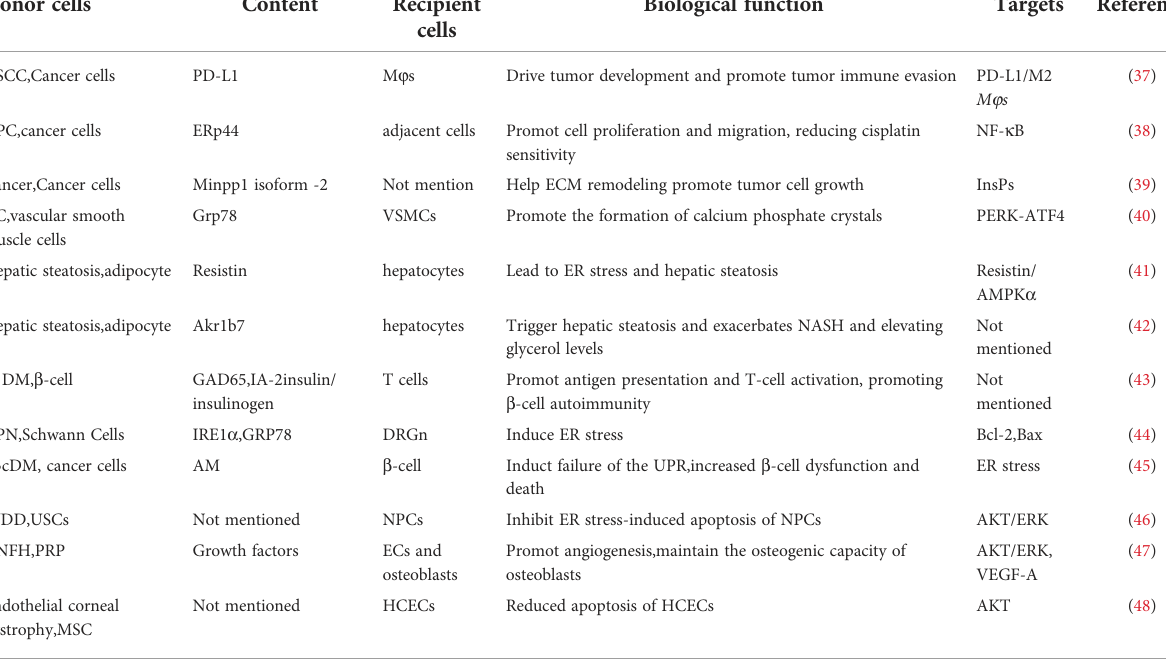
CNSD, central nervous system disease; SCI, spinal cord injury; HNSCC, head and neck squamous cell carcinoma; HUVECs, human umbilical vein endothelial cells; OSCC, oral squamous cell carcinoma; BC, breast cancer; GC, gastric cancer; HER2, human epidermal growth factor receptor 2; NPC, nasopharyngeal carcinoma; HCC, hepatocellular carcinoma; MSC, mesenchymalstemcell;DPN,diabeticperipheralneuropathy;T3cDM,type3cdiabetesmellitus;AD,Alzheimer ’ sdisease;H/R,hypoxia/reoxygenation;BMSC,bonemarrowmesenchymal stemcell;IVDD,intervertebraldiscdegeneration;USC,urine-derivedstemcell;ONFH,osteonecrosisofthefemoralhead;PRP,platelet-richplasma;I/R,ischemia/reperfusion;VC,vascular calci fi cation; HCEC, human corneal endothelial cell; EC, endothelial cell; EPC, endplate chondrocytes;DRGn, dorsal root ganglion neurons; AM,